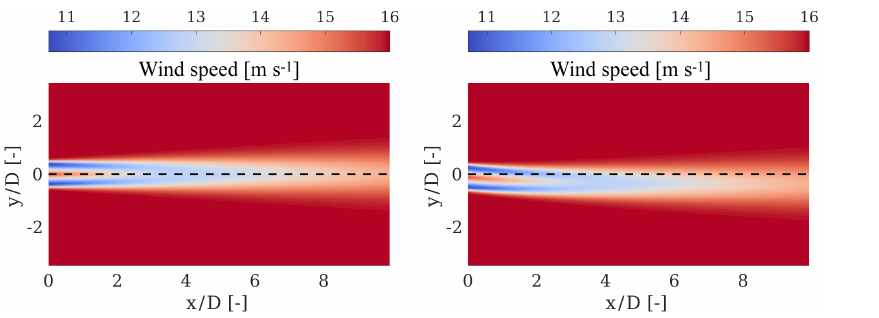
Figure 6. Visualization of two wake situations within a constant wind field of v 0 = 16ms − 1 , axial induction a = 0 . 15, and dissipation rate (cid:15) = 0 . 1.